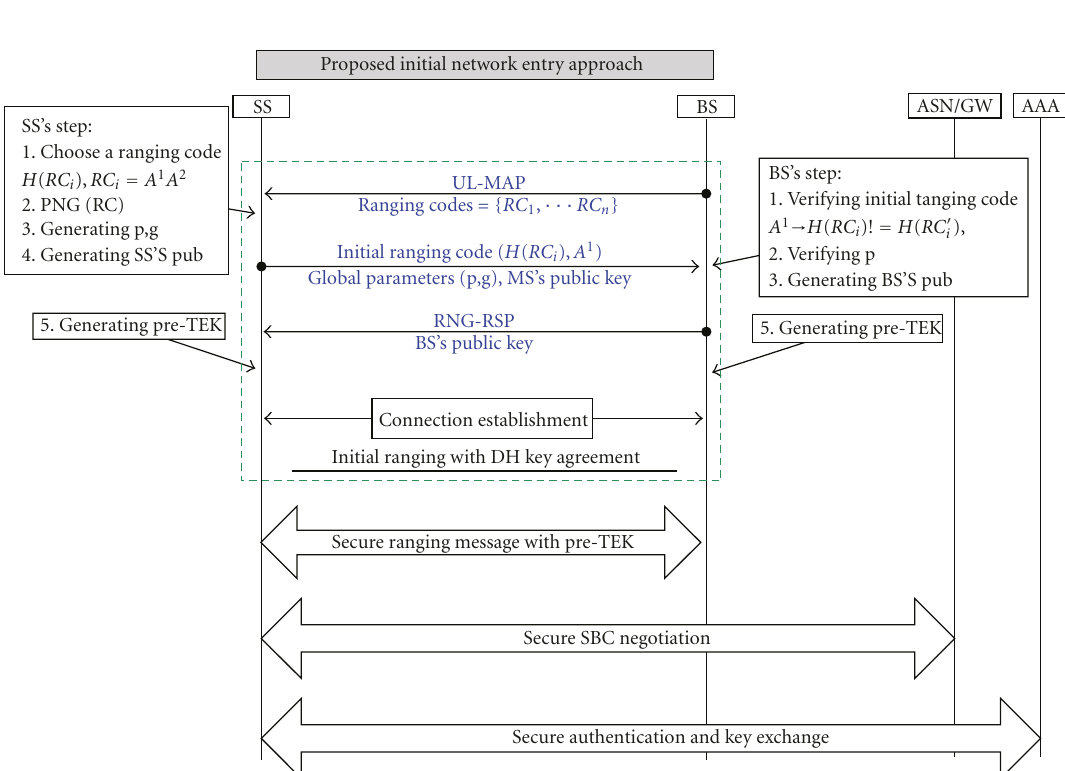
Figure 3: Overview of handover procedure.